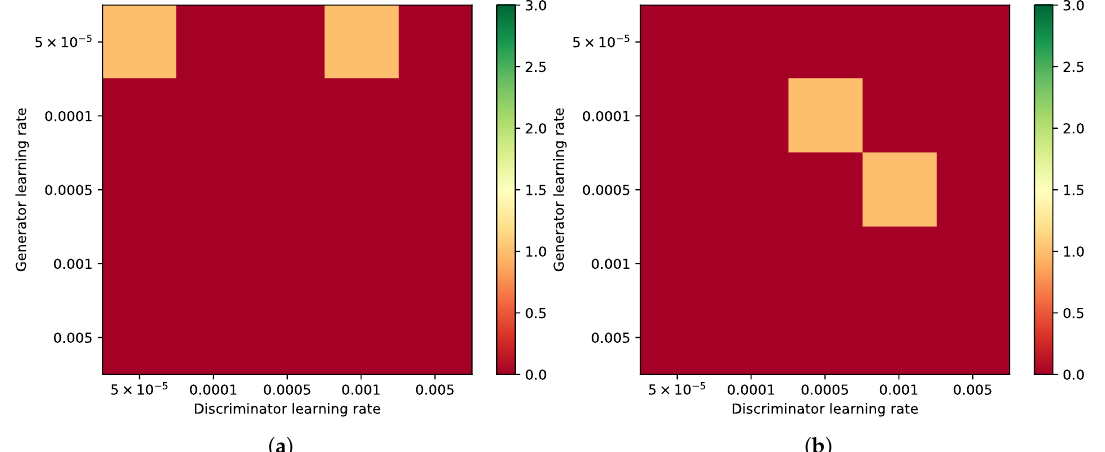
Figure 13. Quality of the generated images when re-initializing all layers of the discriminators. ( a ) No extra training of the discriminator. ( b ) With extra training of the